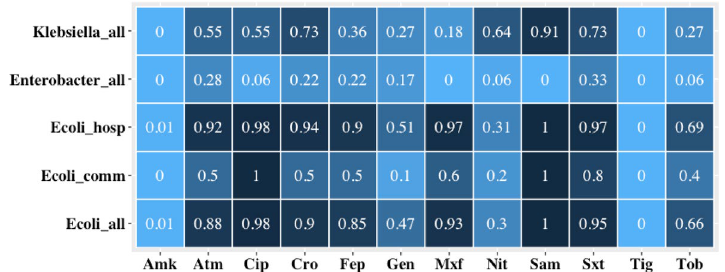
Figure 2. Heatmap showing the proportion of resistant isolates among CRE for 12 of the 17 antibiotics tested. Increasing color intensity denotes increasing proportion of resistant isolates. The three carbapenems tested (ertapenem, imipenem and meropenem) are not shown. Ampicillin and cefazolin are also not shown because isolates were fully resistant. Heatmap includes 96 E. coli (hospital = 86, community = 10), 11 Klebsiella oxytoca and K. pneumoniae pooled, and 18 Enterobacter aerogenes and E. cloacae pooled. Antibiotics: amikacin (Amk), aztreonam (Atm), ciprofloxacin (Cip), ceftriaxone (Cro), cefepime (Fep), gentamicin (Gen), moxifloxacin (Mxf), nitrofurantoin (Nit), ampicillin/sulbactam (Sam), sulfamethoxazole/trimethoprim (Sxt), tigecycline (Tig), and tobramycin